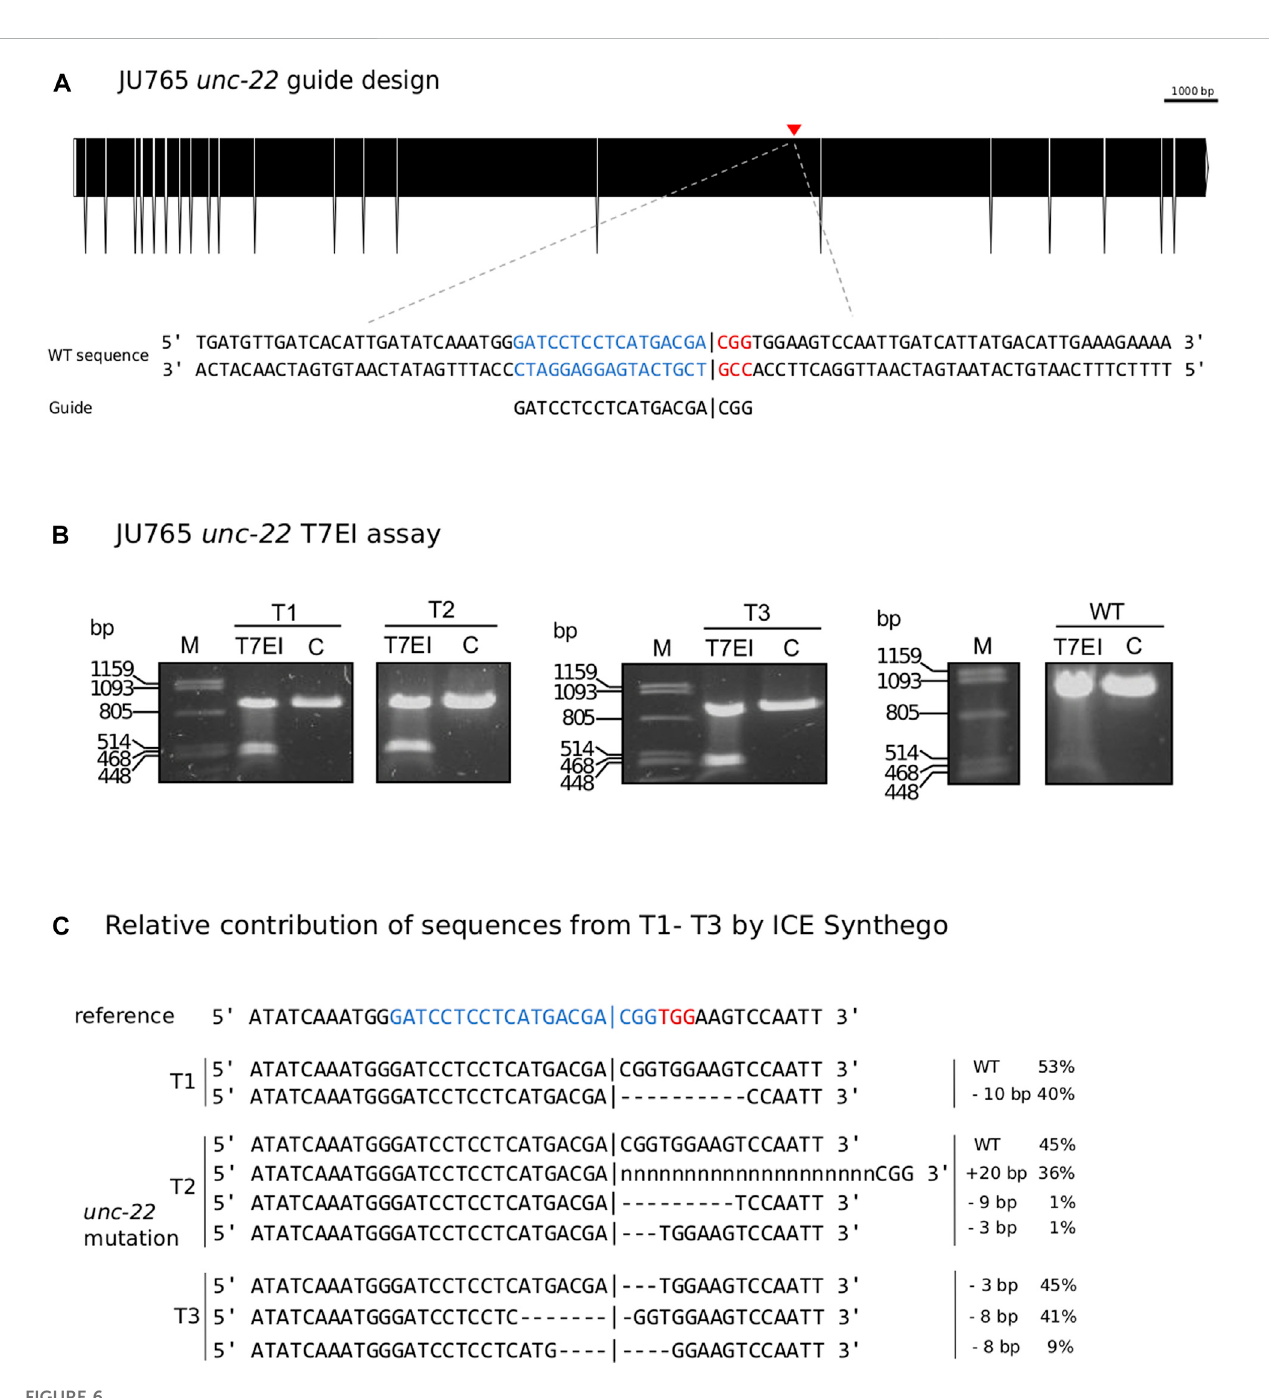
FIGURE 6 (A) CRISPRtargetsite for Propanagrolaimus sp. JU765 unc-22 . Predicted gene structure. Black boxes = exons. Red arrow = CRISPR target region. Zoom into part of exon 16 coding strand with target region (blue) and PAM site (red). Vertical bar indicates the expected Cas9 cleavage site. (B) Representative examples of 3 individuals T1-T3. Agarose gel electrophoresis of T7EI assay after knock-out experiments. Multiple band patterns detect indels. M = Marker Lambda Pst I digest. C = negative control. T1 - T3 = twitchers 1-3. (C) Relative contribution of inferred sanger sequences in edited T1-T3 (PCR product) con fi rms indels in the target region. Target region (blue) and complementary PAM site (red). Vertical bar indicates the expected (actual) Cas9 cleavage site. Dashes indicate deletions and ‘ n ’ indicates insertions. The number of inserted (+) or deleted ( − ) nucleotides are indicated on the right with the proportion of that sequence inferred in the pool. Prediction produced using the Synthego Performance Analysis, ICE Analysis. 2019. v3.0.